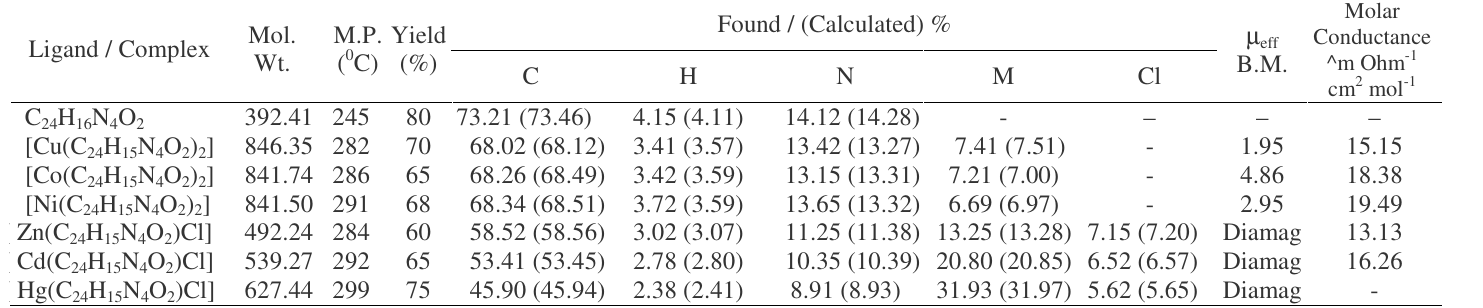
Table 1 Analytical, magnetic susceptibility and molar conductance data of the ligand [HQMAPQ] and its metal (II) complexes